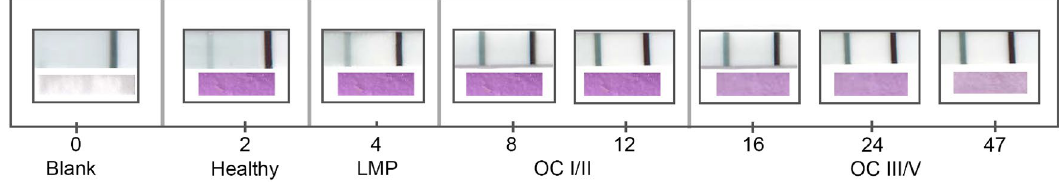
Figure 2. Simulated clinical patient ratios of urinary HE4/CRE. Each image shows a lateral flow strip and corresponding creatinine strip below. In the LFA strip, the left line is the test line and the right line is the control line. * LMP low malignancy potential cyst. The labels below are the ratio of HE4/CRE and the corresponding stage of ovarian cancer given by Liao et al. (2015) and Hellstrom et al. (2010).